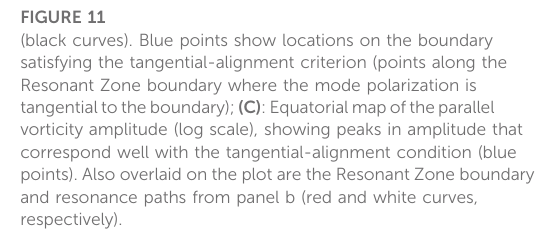
FIGURE 11 (black curves). Blue points show locations on the boundary satisfying the tangential-alignment criterion (points along the Resonant Zone boundary where the mode polarization is tangentialtotheboundary); (C) :Equatorialmapoftheparallel vorticity amplitude (log scale), showing peaks in amplitude that correspond well with the tangential-alignment condition (blue points). Also overlaid on the plot are the Resonant Zone boundary and resonance paths from panel b (red and white curves,